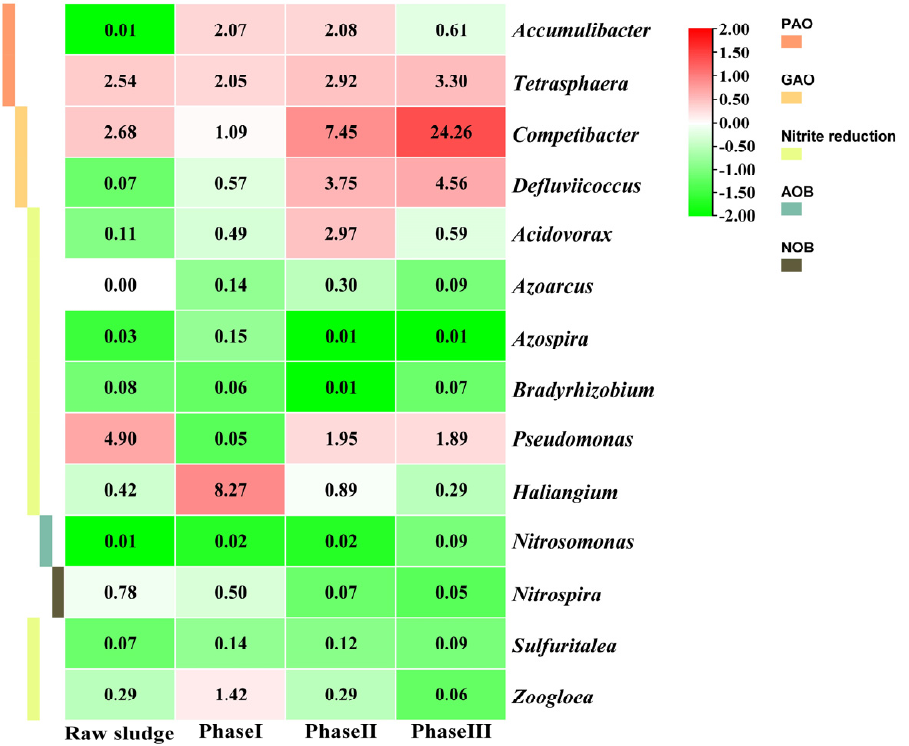
Figure 4. Relative abundance of known functionally relevant microorganisms for nitrogen and phosphorus removal during the experiment.